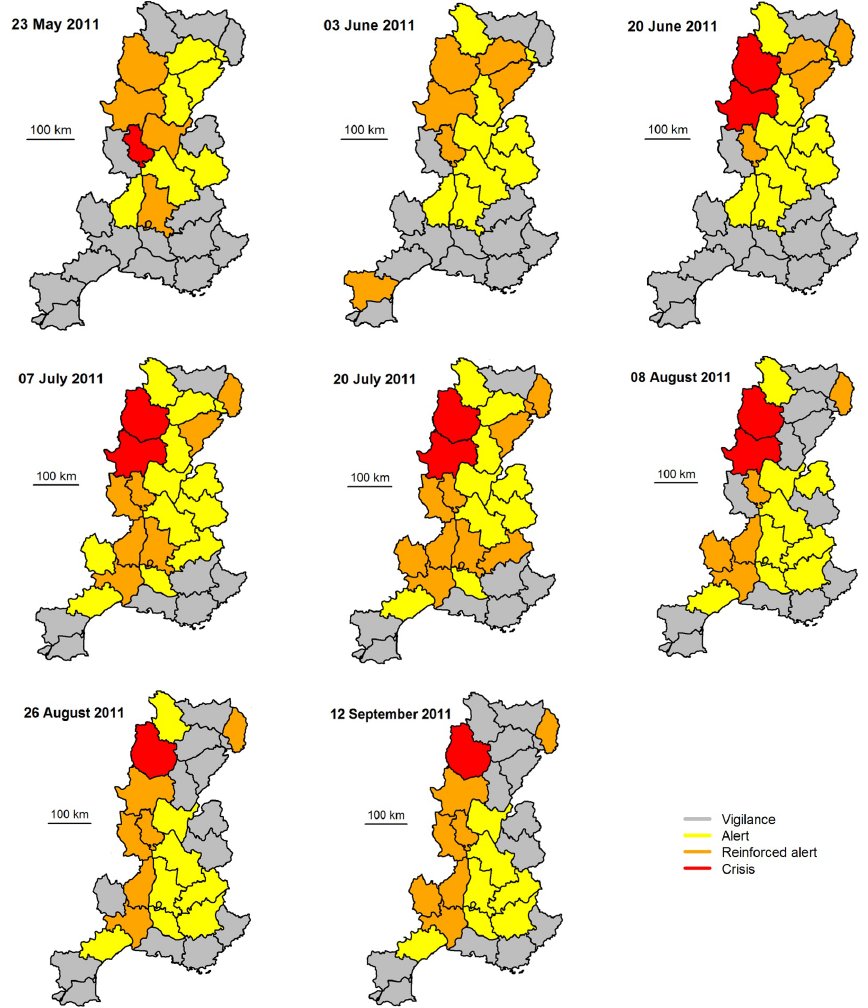
Figure 13. Most severe water-restriction level adopted at the department-level scale for several dates between May and September 2011 (source: French Ministry of Ecology).